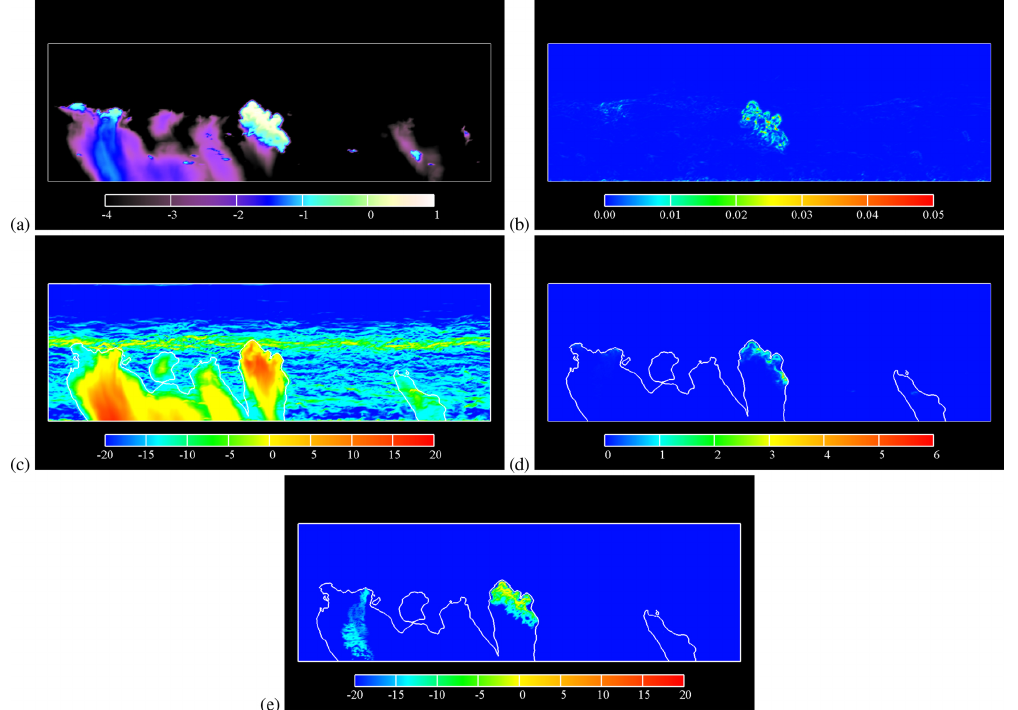
Figure 9. Liquid water content (LWC), energy dissipation rate (cid:15) , and radar reflectivity factors for S-band microwaves in the vertical cross section: (a) LWC in a logarithmic scale (i.e., log 10 LWC – gm − 3 ), (b) (cid:15) (m 2 s − 3 ), (c) Z dB (dBZ), (d) Z dB − (Z incoh + Z CB ) dB (dB), and (e) Z dB (dBZ). The solid lines in (c) – (e) indicate the isoline of Z dB PBc